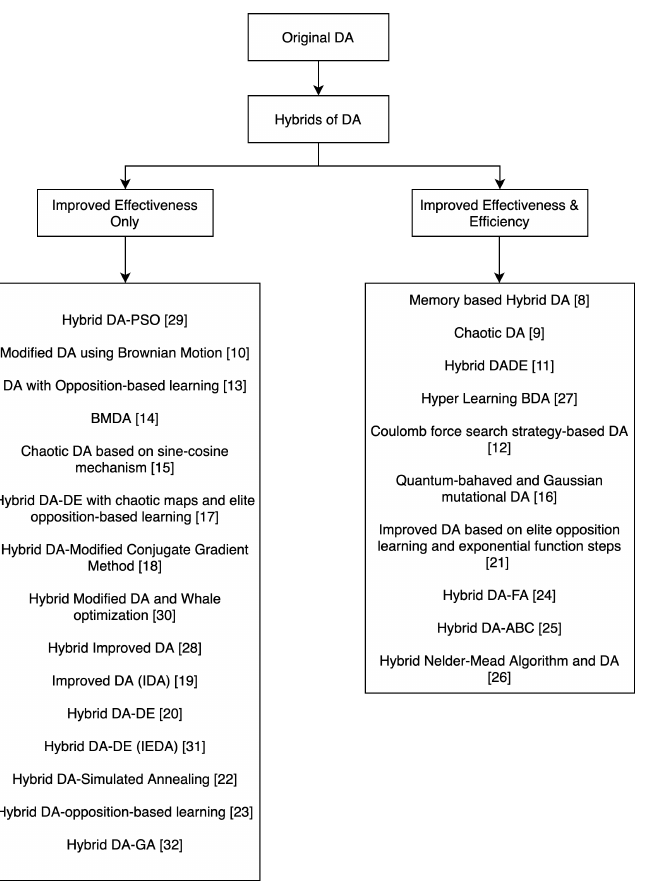
Figure 5. Taxonomy categorizing hybrids of DA in terms of improved effectiveness and efficiency.